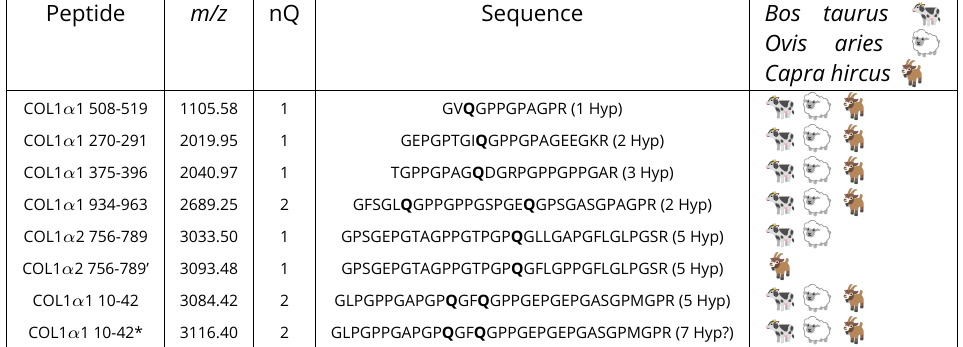
Table 1. List of peptides used in the analysis, using the (Brown et al., 2021) nomenclature for ZooMS marker peptides. Sequences for each mass were inferred from Mascot analysis of parchment datasets (SF and JW personal communication). All masses are consistent with typical hydroxylation patterns of collagen except where indicated by “?”. To differentiate the peptide COL1 ↵ 2 756-789 from cow and sheep from the goat one, we have marked the latter with “’”. Similarly, the peptide COL1 ↵ 1 10-42 with 7 hydroxyprolines is marked with